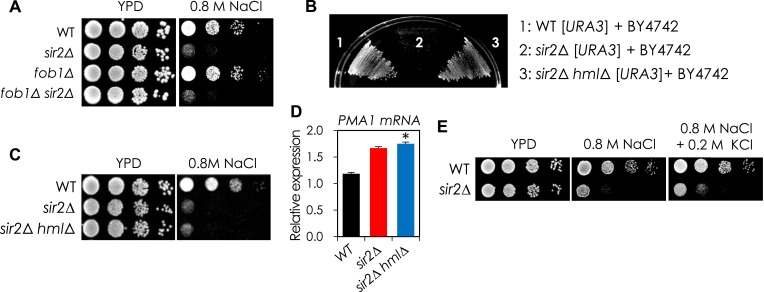
The NaCl sensitivity of the sir2Δ mutant was affected neither by Fob1 nor by pseudodiploid state.(A) Deletion of FOB1 gene does not affect NaCl sensitivity in WT and sir2∆. Each cell was spotted onto YPD plates with 0.8 M NaCl and incubated at 30°C for 3 days. (B) Deletion of HMLα from the sir2∆ mutant restored the mating phenotype. Each of mating type a cells (WT [URA3], sir2∆ [URA3], and sir2∆ hml∆ [URA3]) and α cells (BY4742) was seeded together into YPD medium at an initial OD600 = 0.2 and then incubated at 30°C for 1 day. Five μl of the cell culture was collected and spread onto synthetic minimal plate containing leucine and histidine. (C) Deletion of HMLα does not affect NaCl sensitivity in sir2∆ mutant. (D) Deletion of HMLα does not affect PMA1 mRNA level in sir2∆ mutant. The PMA1 mRNA level of each cell was analyzed by qRT-PCR (*, vs WT in an indicated strain, p < 0.005). (E) Addition of KCl did not rescue the NaCl sensitivity of sir2∆ cells. Each cell was spotted onto YPD plates containing 0.8 M NaCl with or without 0.2 M KCl and incubated at 30°C for 2 days.